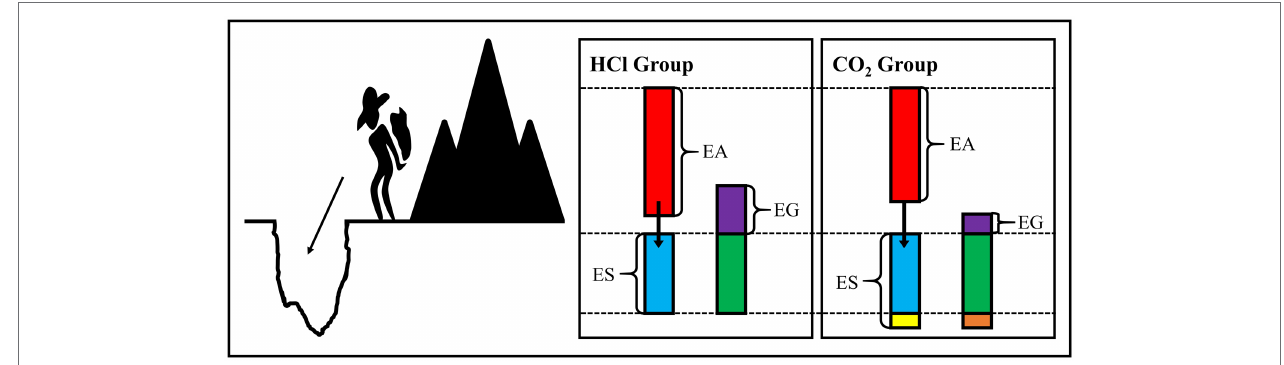
FIGURE 6 | Diagram for “cut and cover hypothesis.” EA, energy availability; ES, energy for survival; EG, energy for